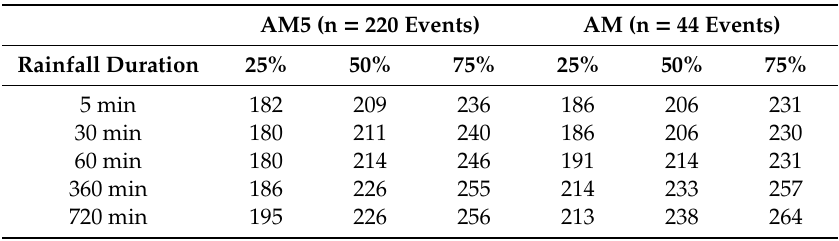
Table 5. Intercept of the linear trend lines fitted to the 25%, 50%, and 75% data. Thus, results indicate the Julian date at the start of the investigation period (i.e., year